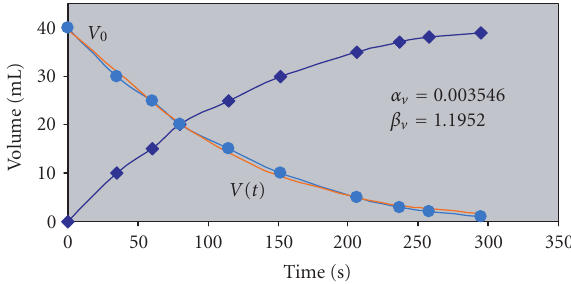
Figure 3.12. Time dependence of the volume of the liquid beer phase flowing out of the foam (dark blue), the portion of fluid beer in the foam (blue) and fitted curve